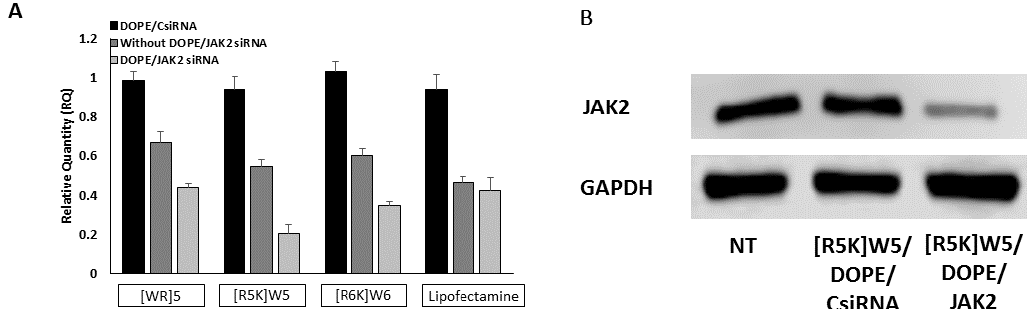
Figure 8. Silencing Janus kinase 2 (JAK2) in MDA-MB-231 Cells: ( A ) Control siRNA (CsiRNA, only delivered with DOPE) or targeting selected protein (delivered with or without DOPE) were delivered using the designed peptides at N/P ratio of 20. All relative quantities were normalized based on mRNA levels of cells treated with normal saline (not shown). All relative quantities for targeted siRNAs were significantly different from the CsiRNA group, and all mRNA levels for targeted siRNA groups were significantly di ff erent from the corresponding ‘without DOPE’ levels ( p < 0.05). ( B ) JAK2 protein level was quantified for cells treated with CsiRNA and JAK2 siRNA (delivered by [R5K]W5/DOPE) using western blot.